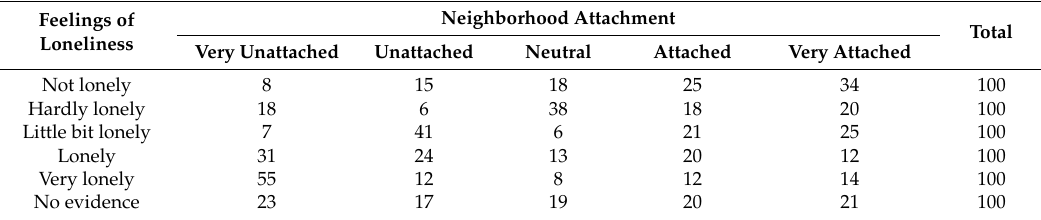
Neighborhood Attachment